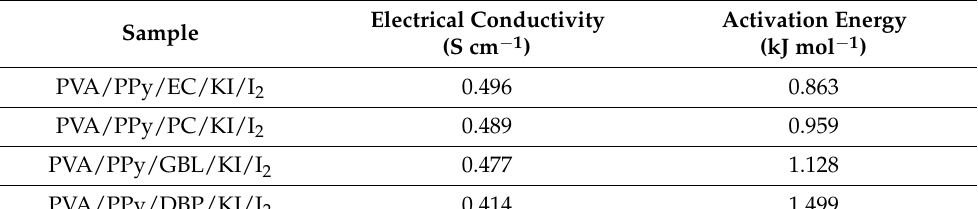
Figure 5. Electrical conductivity – temperature plots of the PVA/PPy/KI/I 2 electrolyte with various